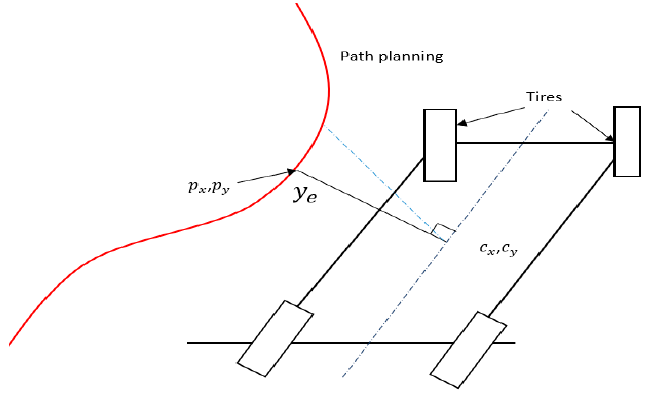
Figure 3. Four-wheeler model and perpendicular distance to the trajectory.